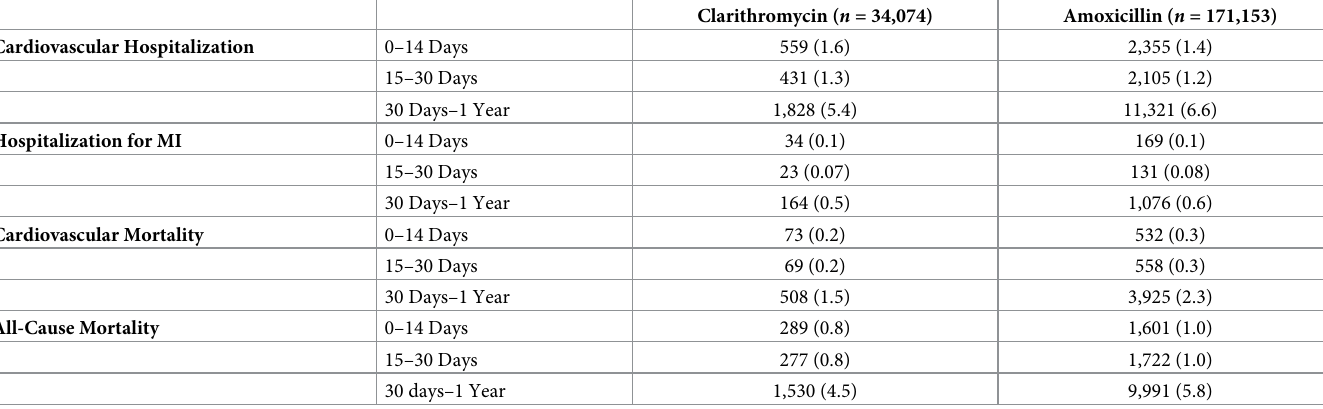
Table 2. Clinical outcomes in the observational cohort study (unadjusted counts and percentages).